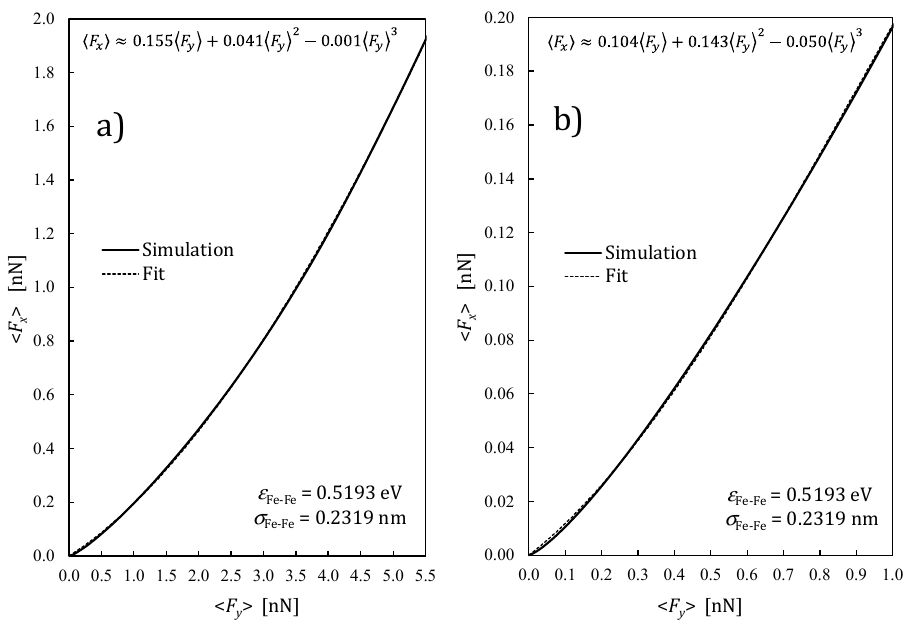
Figure 3. The simulated and polynomially fitted dependence of the averaged lateral (friction) force on the normal (loading) force in the case of iron–iron friction at the atomic level: ( a ) a wide range of load and ( b ) a low load range.